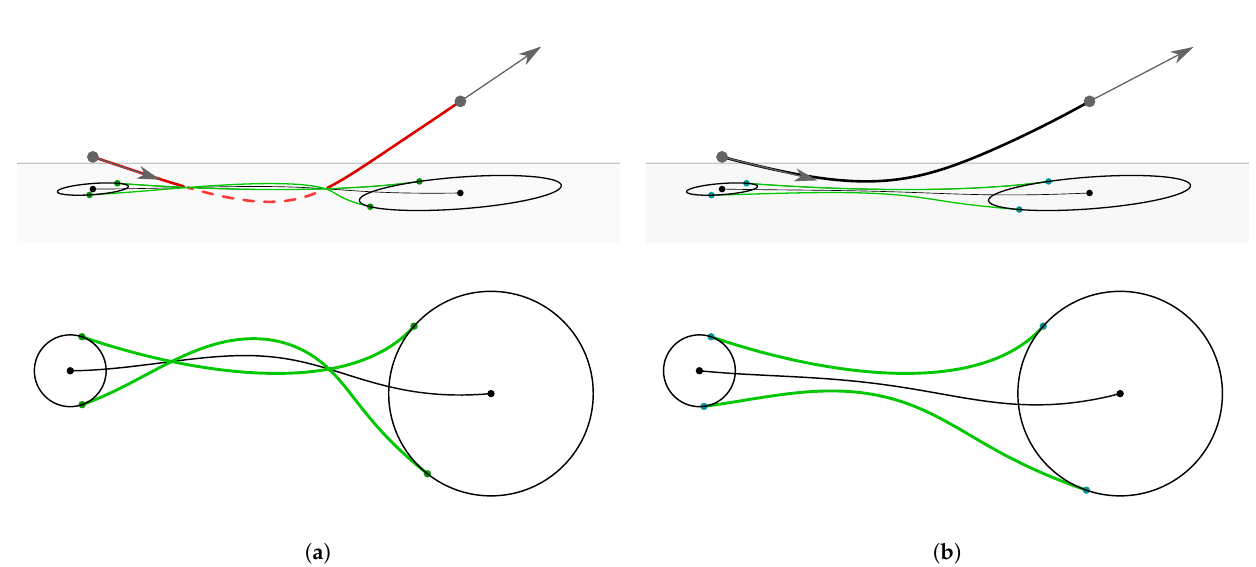
Figure 6. ( a ) The envelope curves intersect each other. ( b ) By modifying the value of u i in (11), we obtain that f ( t ) > 0; thus, we resolve the intersections. With this solution, the location of one of the touching points on the second circle is